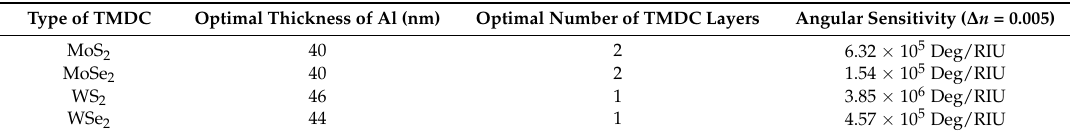
Table 3. Variation of the angular sensitivity as a function of number of MX 2 layers with various thickness of Al thin film.